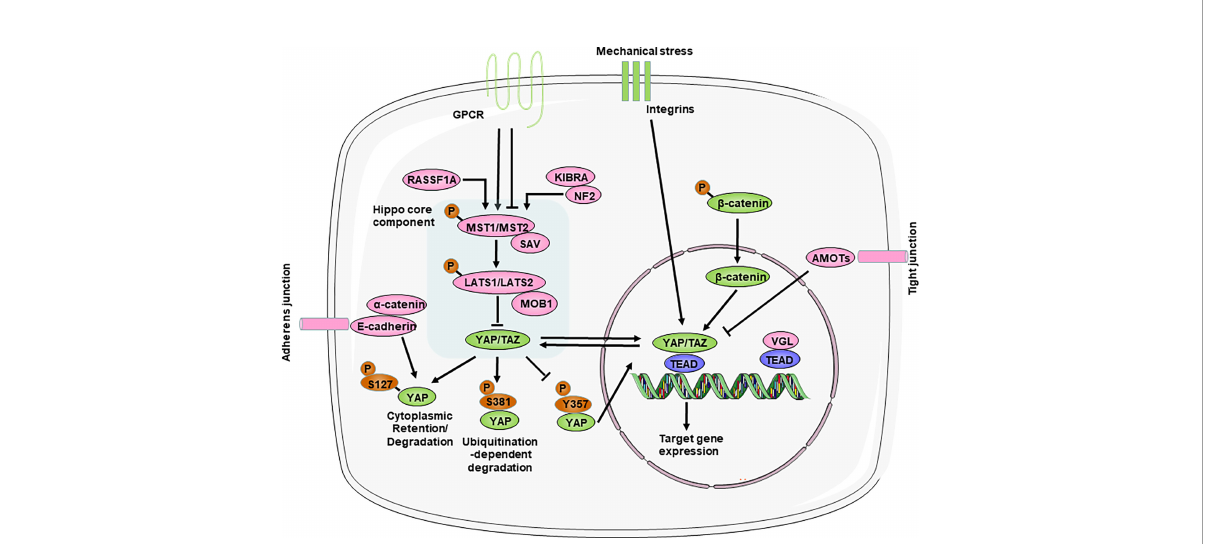
FIGURE 1 Overview of the Hippo-YAP pathway. The core components of the Hippo-YAP pathway contain kinases mammalian Ste20-like kinases 1/2 (MST1/2) and Large tumor suppressor homolog 1/2 (LATS1/2), their cofactors Salvador (SAV) and scaffolding proteins MOB domain kinase activator 1A/B (MOB1A/B), the transcription co-activators Yes-associated protein (YAP) and transcriptional co-activator with PDZ-binding motif (TAZ) and the TEAD1 – TEAD4 family of transcription factors. When the Hippo-YAP pathway is at the “ ON ” status (red), phosphorylated MST1/2 activates the phosphorylation of LATS1/2, which in turn phosphorylate and promote the degradation of the YAP and TAZ. When the Hippo-YAP pathway in at the “ OFF ” status (green), YAP/TAZ are dephosphorylated and accumulate in the nucleus, where they bind with TEADs to induce gene transcription. Various upstream mediators, such as adhesion proteins, mechanotransduction, and other signaling pathways, directly or indirectly to regulate the activity of YAP. For relationship among signalings, arrow represents positive regulation and transverse line represents negative regulation. AMOT, angiomotin; GPCR, G protein – coupled receptors; KIBRA, kidney and brain protein; NF2, neuro fi bromin 2; RASSF1A, ras association domain-containing protein 1A; VGL, vestigial like